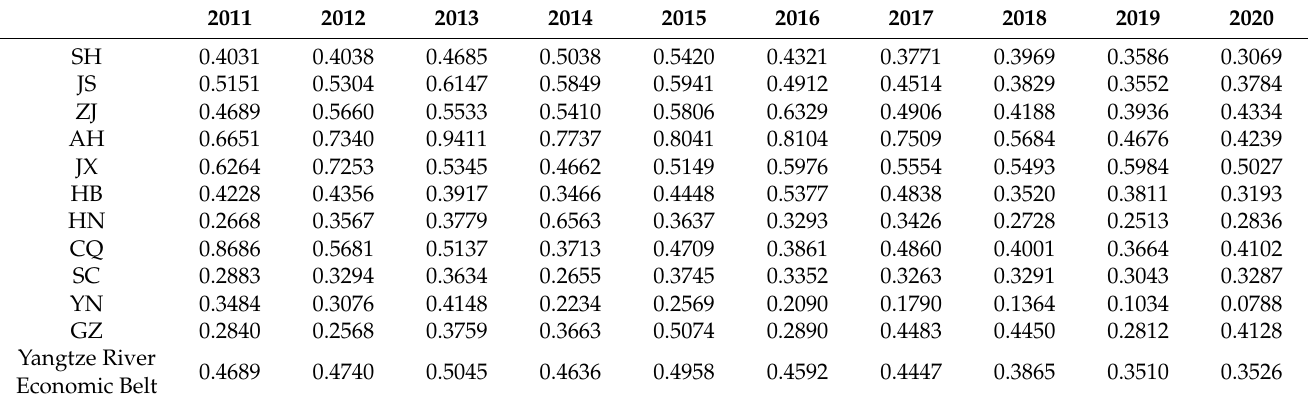
Table 2. Green Financial Development Index of 11 provinces and cities in the Yangtze River Economic